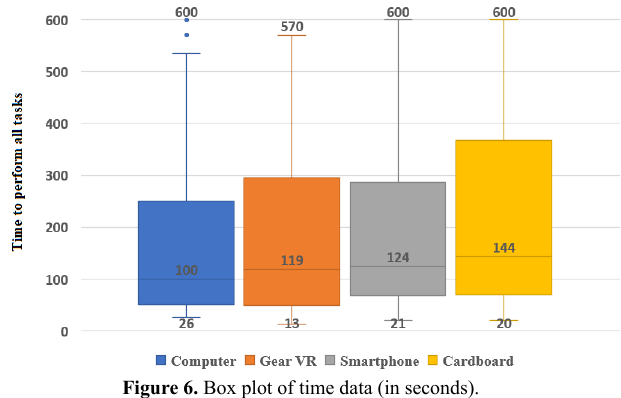
Figure 6. Box plot of time data (in